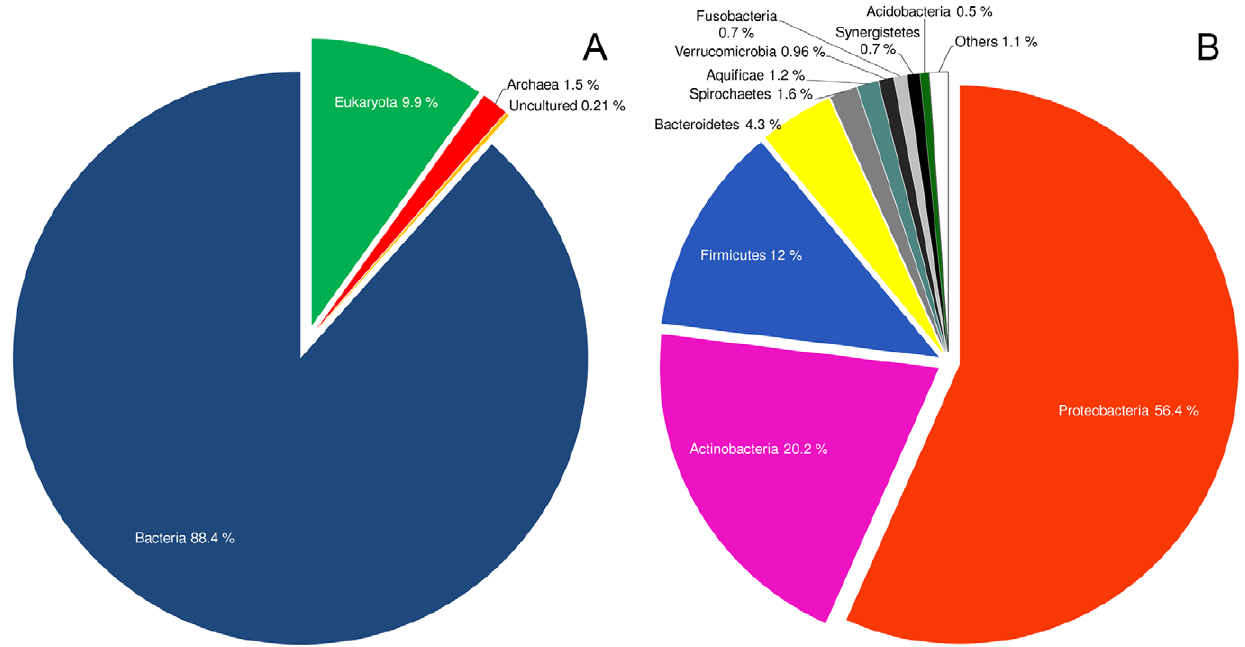
Figure 6. Nicotinamidase distribution (A) in biology and (B) among bacteria.